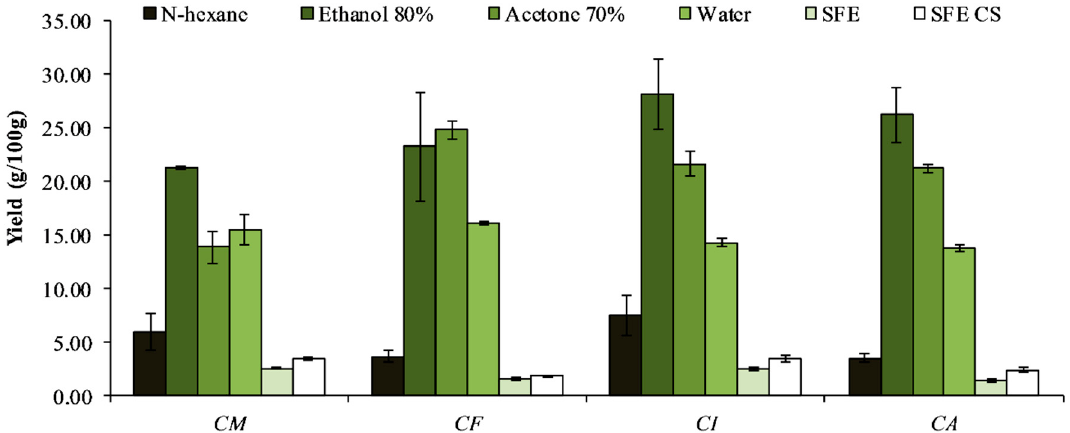
Figure 1. Yield (g / 100 g) determined on the matrix of dried leaves of four Calendula taxa (CM: C. maritima ; CF: C. fulgida ; CI: C. hybrid ( maritima × fulgida ); CA: C. arvensis ), extracted with different solvents (Results of the statistical analysis are shown in Supplementary Table S1).